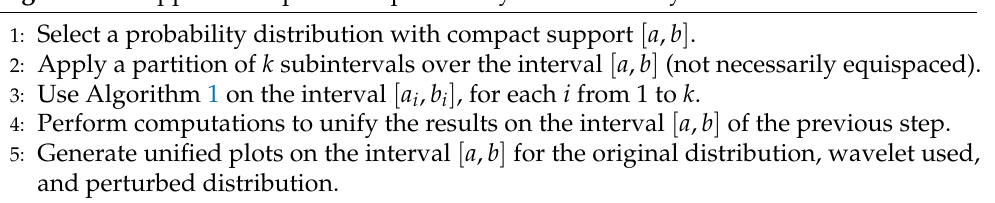
Algorithm 2 Approach to perturb a probability distribution by